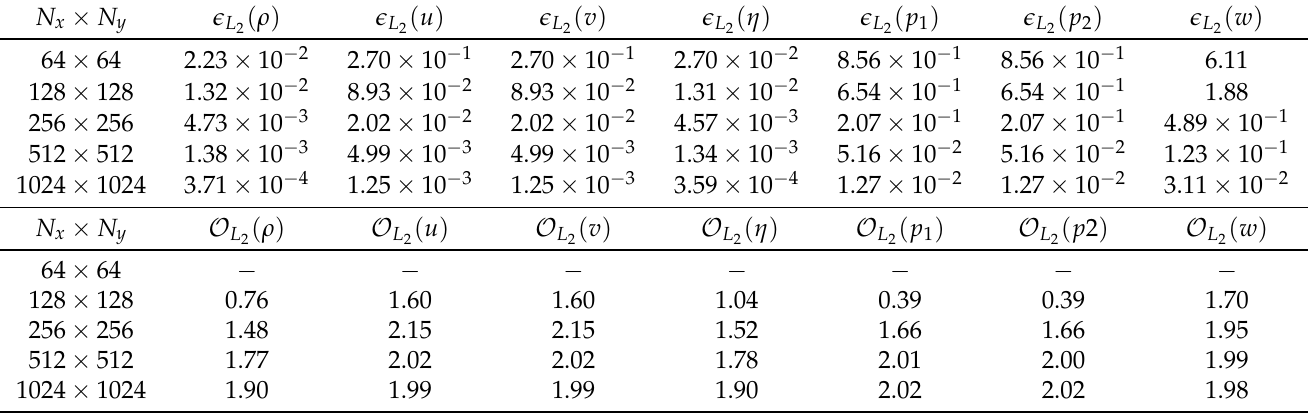
Table 1. Numerical convergence table for the 2D stationary bubble reference solution obtained from solving (21). N x and N y denote the number of elements in the x and y directions. The L 2 norm of the errors for a set of representative variables with respect to the exact solution, are reported in the upper part and the corresponding convergence order is reported in the lower one. Parameters used in O 2 the simulations are γ = 10 − 3 , µ = 10 − 2 , c s = 1, α = 10 − 2 and β = 10 − 3 . Final time is t =